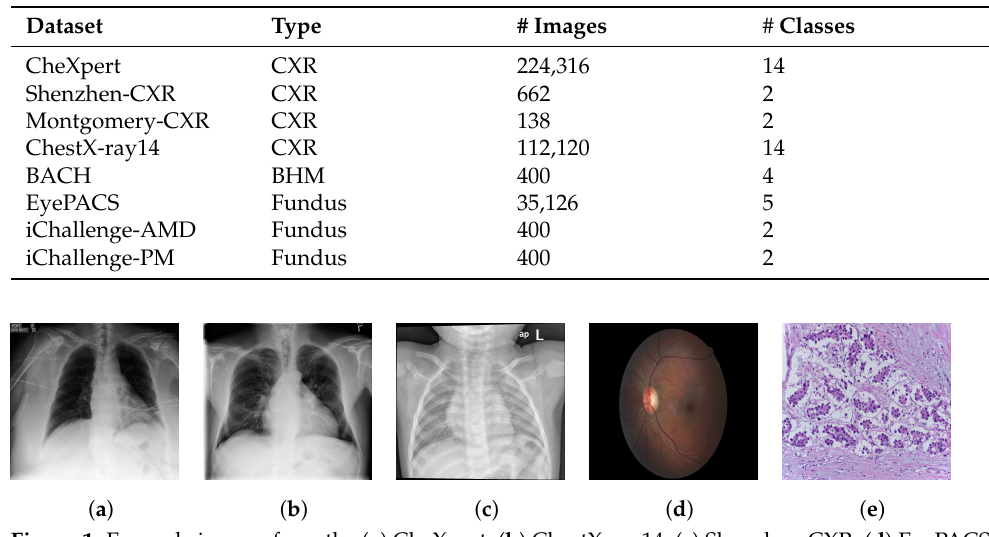
Table 1. The type, number of images, and number of classes for each medical dataset considered.